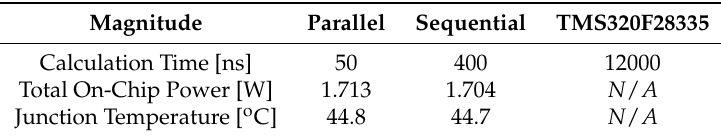
Table 7. Calculation time for proposed